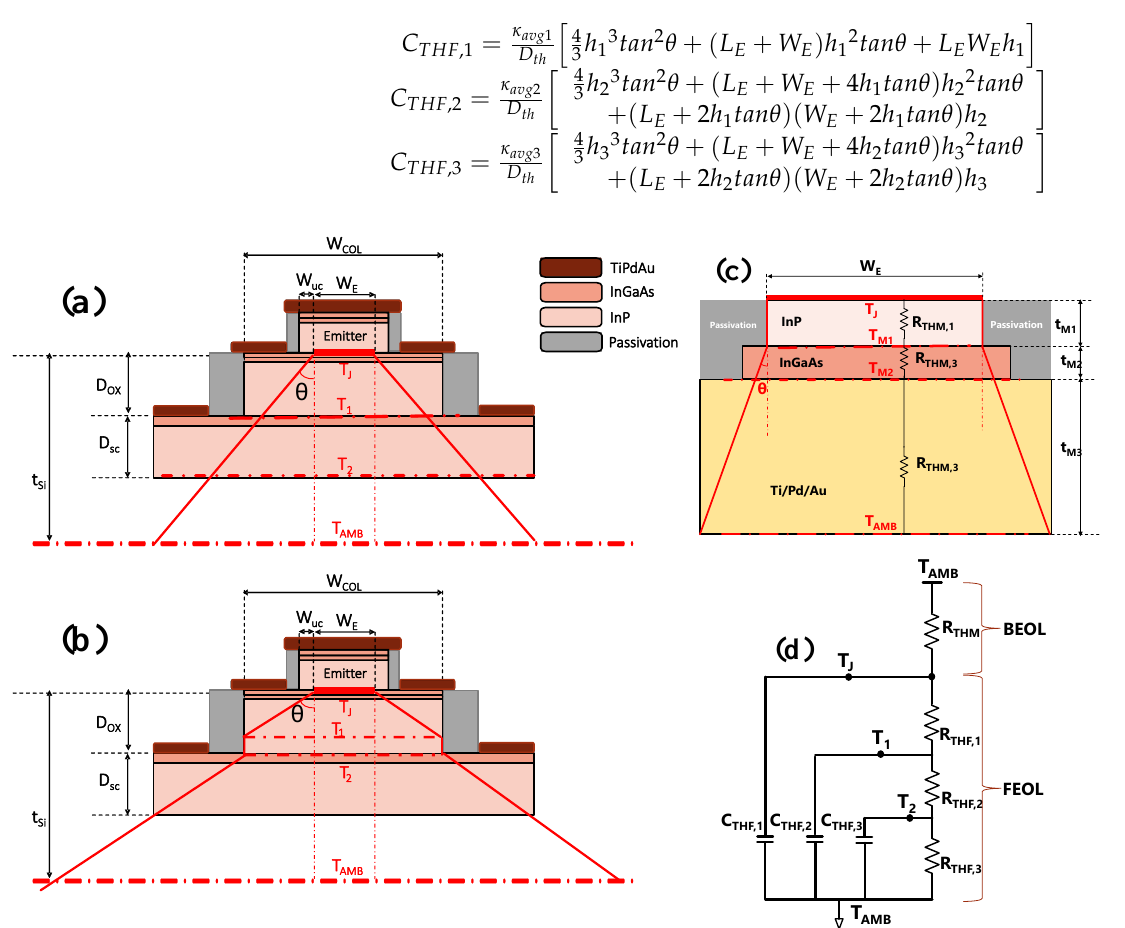
Figure 9. Two scenarios of heat flow through the HBT structure ( a ) θ < θ C , ( b ) θ > θ C ; distributed electro–thermal network for the ( c ) upward and ( d ) downward heat flow.